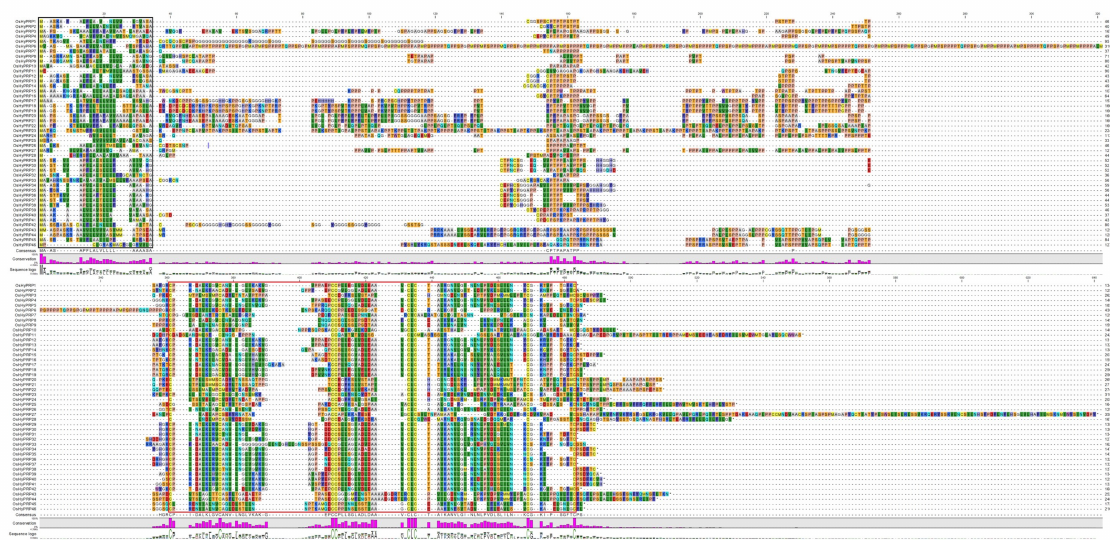
Figure 1. The multiple sequence alignment of OsHyPRPs showing conserved regions. The conserved amino acid residues in the black box are N-terminal signal peptides (may extend further for several proteins due to alignment constrains), while the C-terminal 8CM of OsHyPRPs is marked in the red box. The 8CM region is typical to the other 8CM protein with a conserved eight cysteine skeleton. The region in-between the black and red boxes showed the non-conserved proline-rich region, which is atypical to the proline-rich cell wall structural